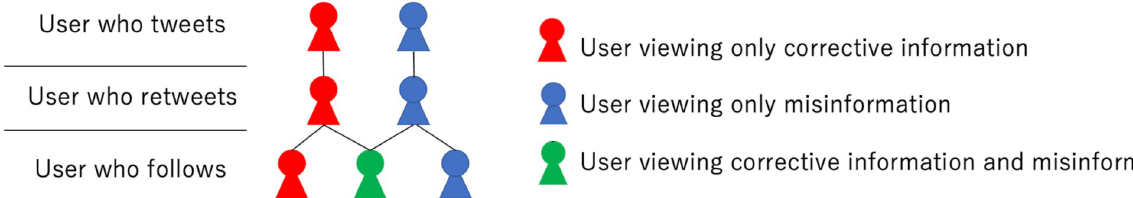
Fig 2. Illustration of the estimated number of users viewing tweets.